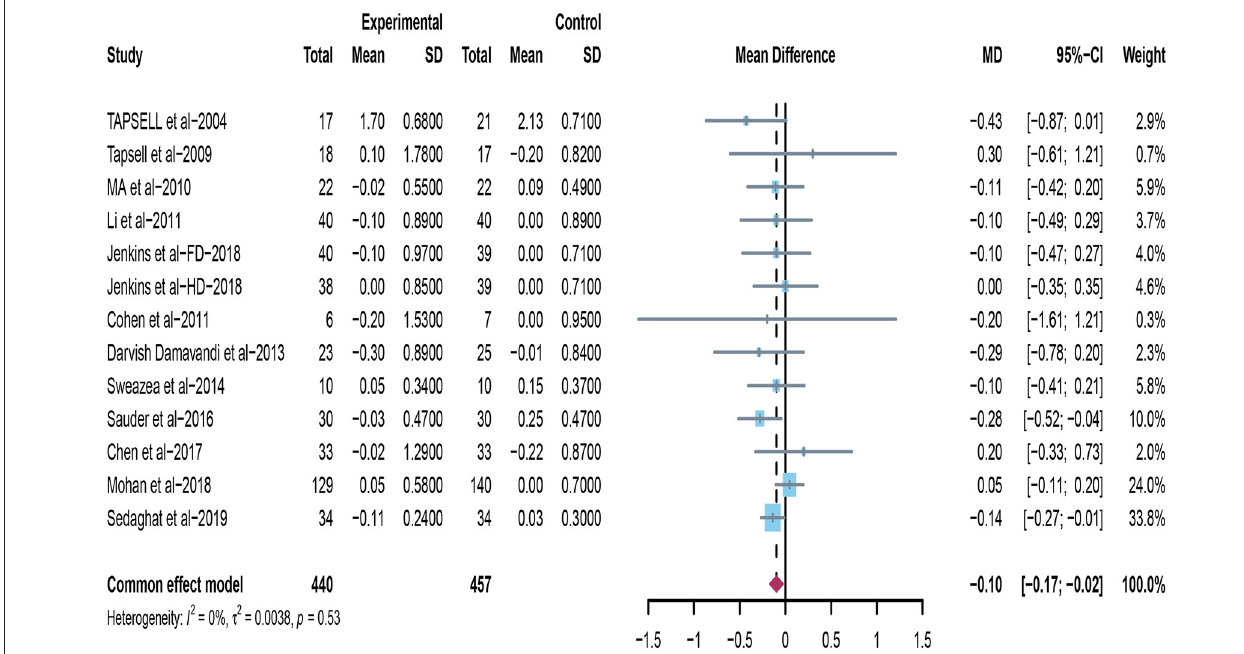
FIGURE 6 | Effect of peanuts and tree nuts supplementation on triglyceride (mmol/l) in patients with type 2 diabetes.